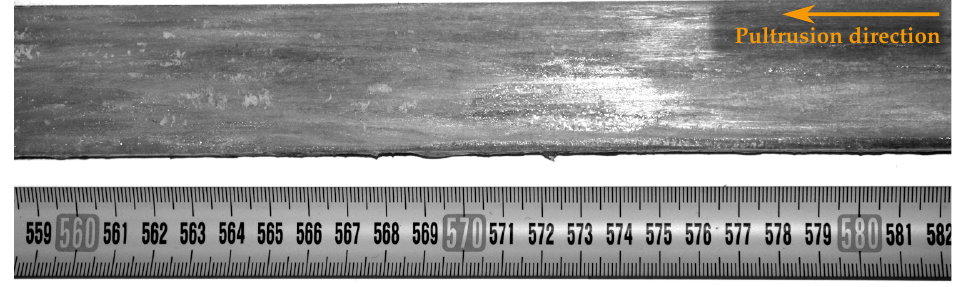
Figure 13. Material with slight deformation at